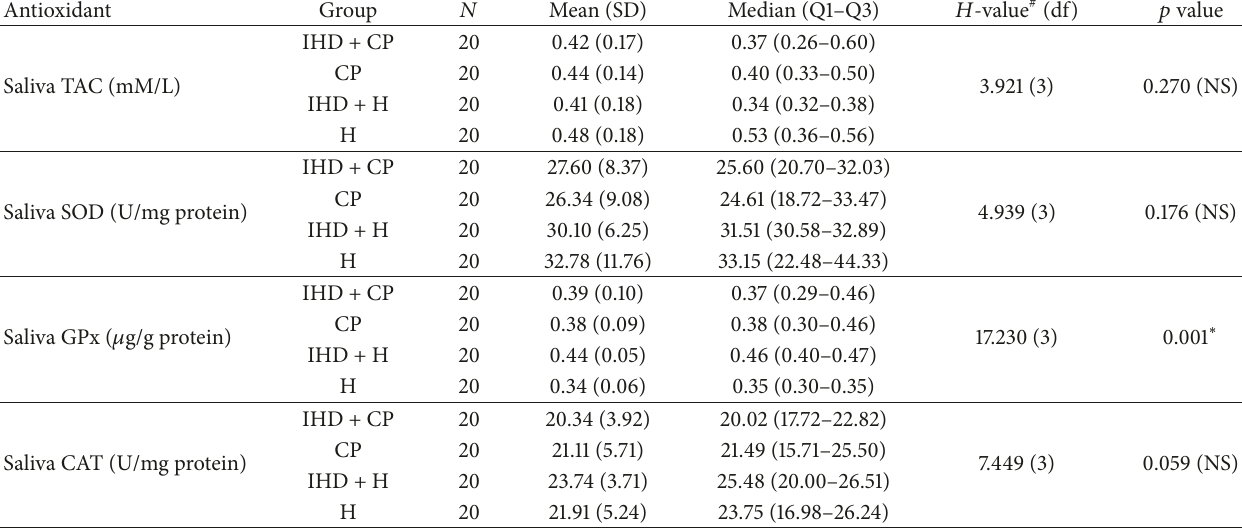
Table 3: Comparison of salivary levels.